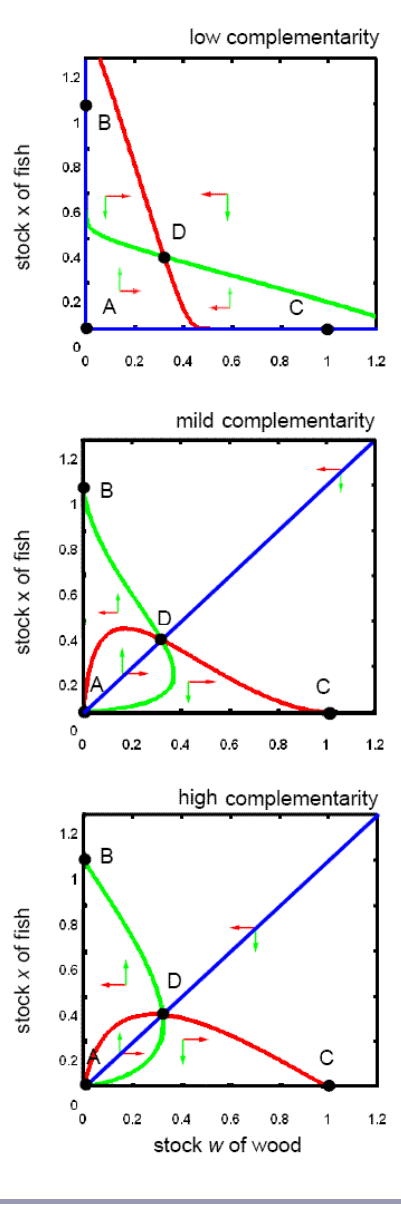
Fig. 5. Phase diagrams for the ecosystem’s dynamics with interspecies competition for different levels of complementarity between ecosystem services in consumption, s . Dynamics in each diagram are characterized by dx/dt > 0 (< 0) left (right) of the green line, and dw/dt > 0 (< 0) below (above) the red line. Blue lines indicate saddlepaths. The upper diagram shows the case of low complementarity ( s = 0.95), the middle diagram displays mild complementarity ( s = 0.4) and the lower diagram high complementarity ( s = 0.05). Parameter values for all diagrams: r x = r w = 0.5, k x = k w = 1, g x = g w = 0.25, n x = n w = 1, a = 0.6, n =